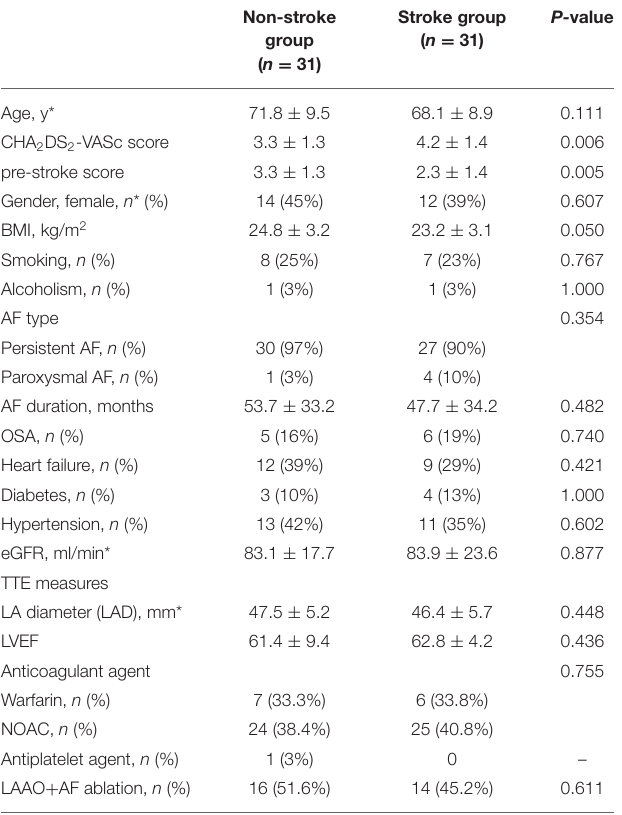
TABLE 1 | The demographic and clinical characteristics for all participants.